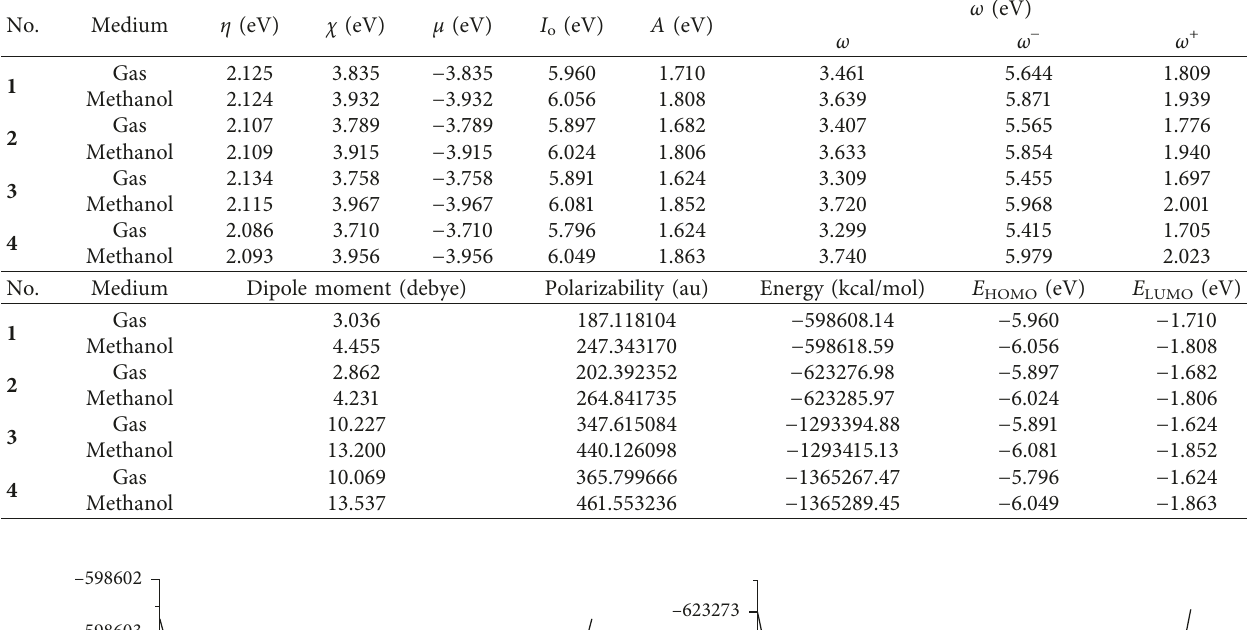
Table 2: Chemical reactivity indices obtained using the DFT method in gas and methanol mediums.